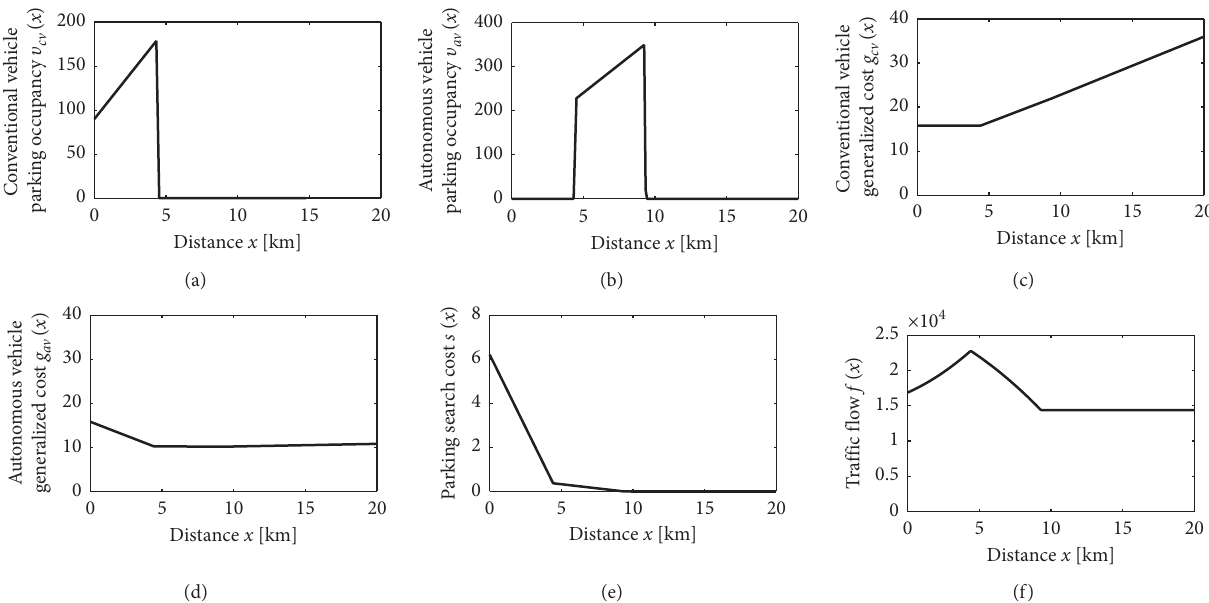
Figure 11: (a) Parking occupancy of CVs, (b) parking occupancy of AVs, (c) generalized cost of CVs, (d) generalized cost of AVs, (e) parking search cost, and (f) traffic flow.